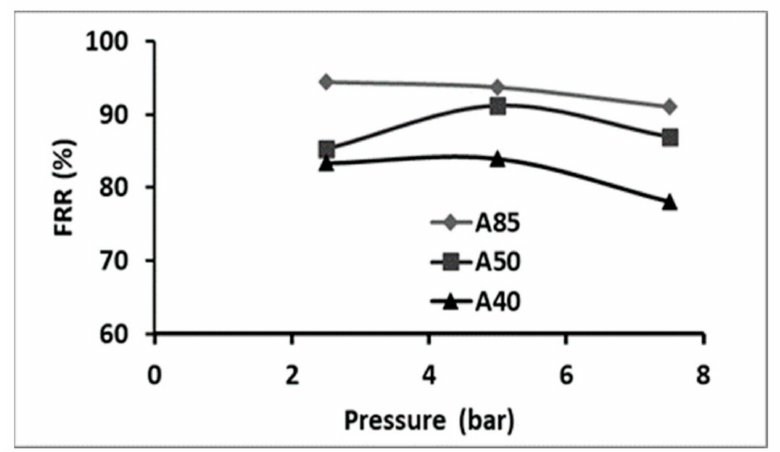
Figure 10. Evaluation of the FRR with pressure for the different composite